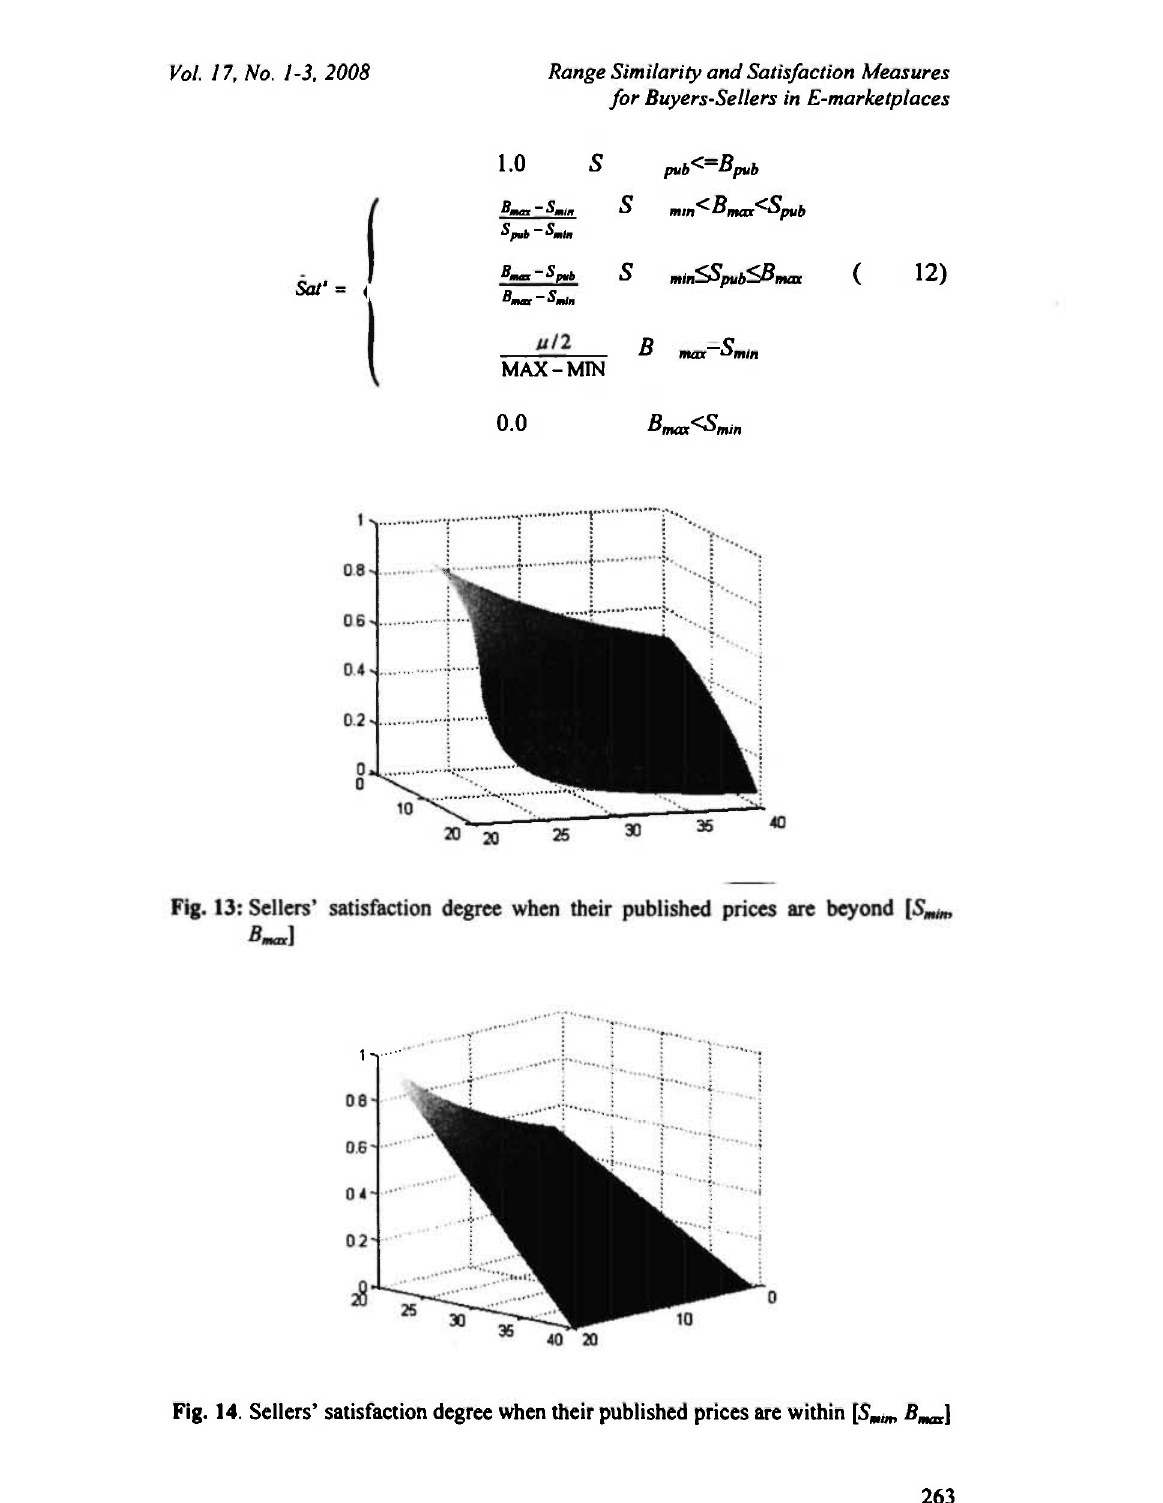
Fig. 14. Sellers' satisfaction degree when their published prices are within [S Bim B ^]